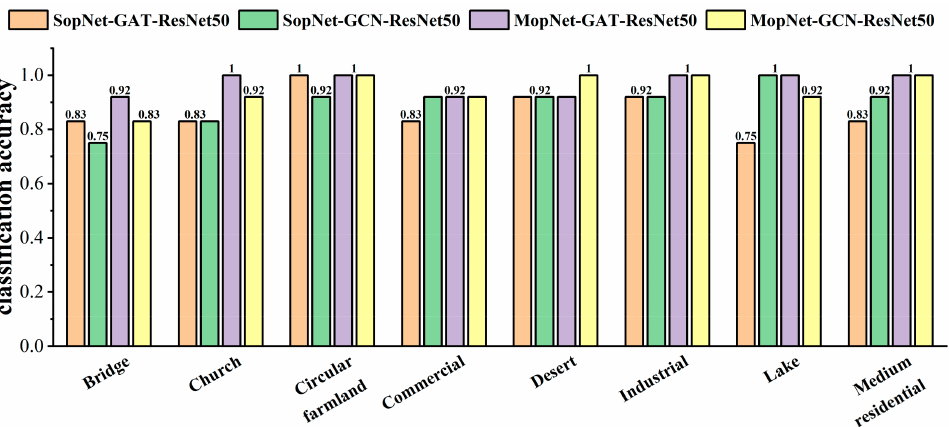
Figure 9. Classification accuracies calculated by MopNet and SopNet on some typical classes of the OPTIMAL-31 dataset.